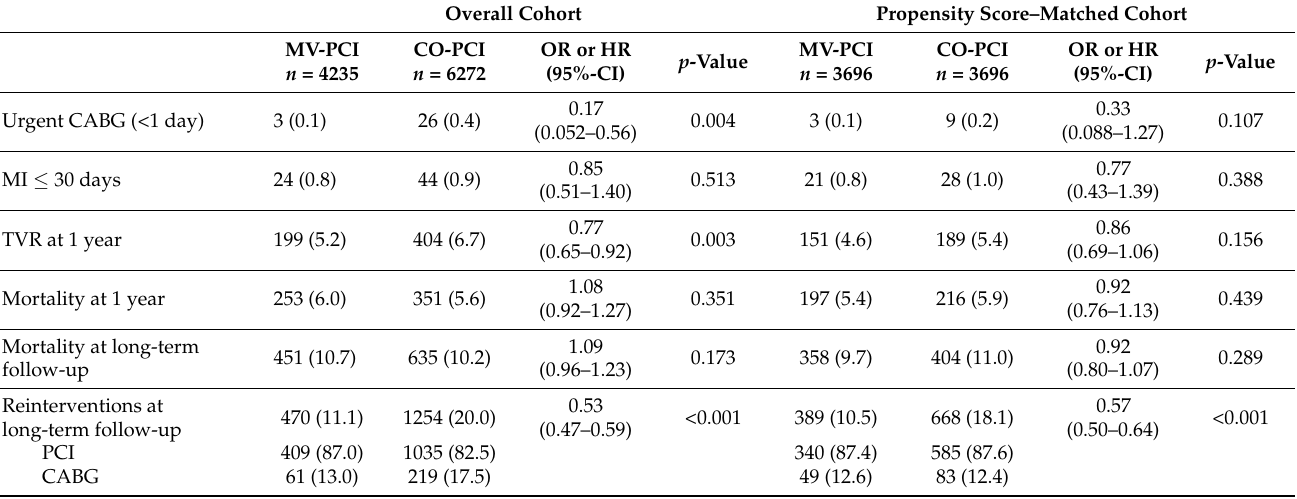
Table 2. Outcome